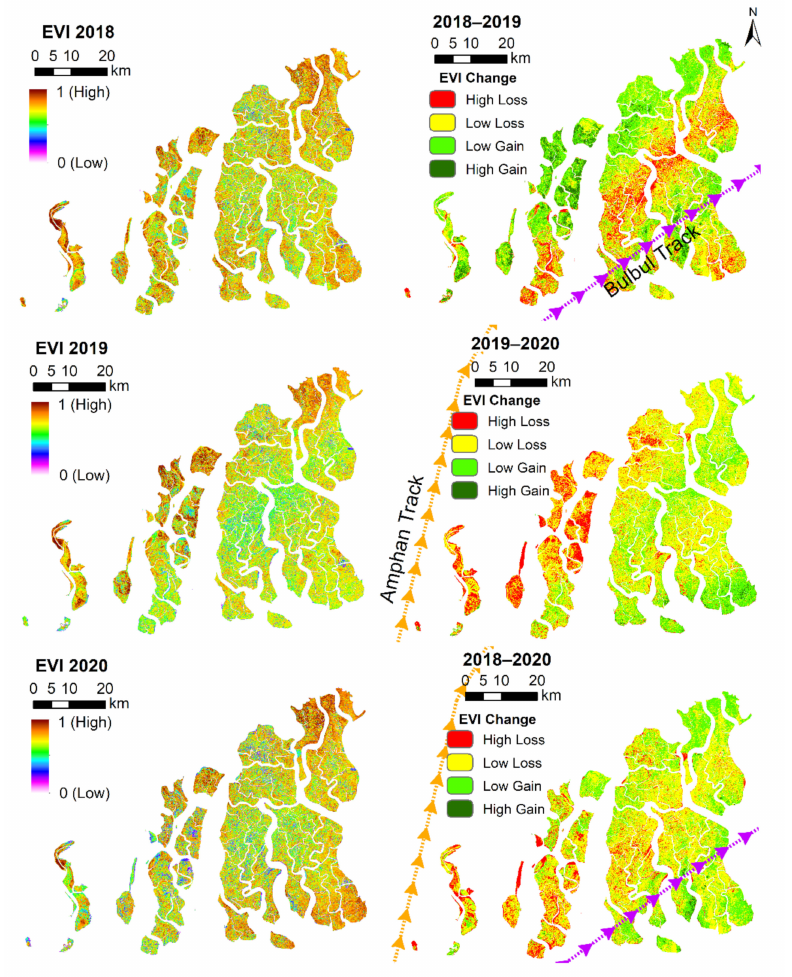
Figure 11. Change in the enhanced vegetation index (EVI) of the mangroves after two consecutive cyclones in 2019 and